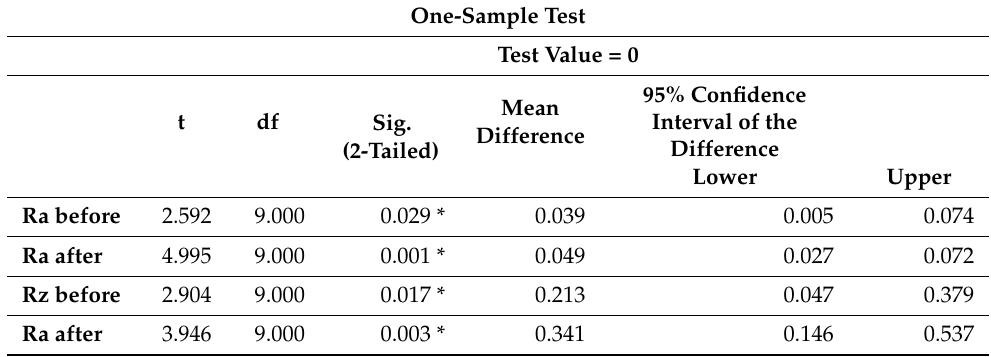
Table 2. One-sample test for samples scanned on an area of X Scan size 10 µ m and Y Scan size 10 µ m before fluoridation and after fluoridation. The values are presented in micrometers.